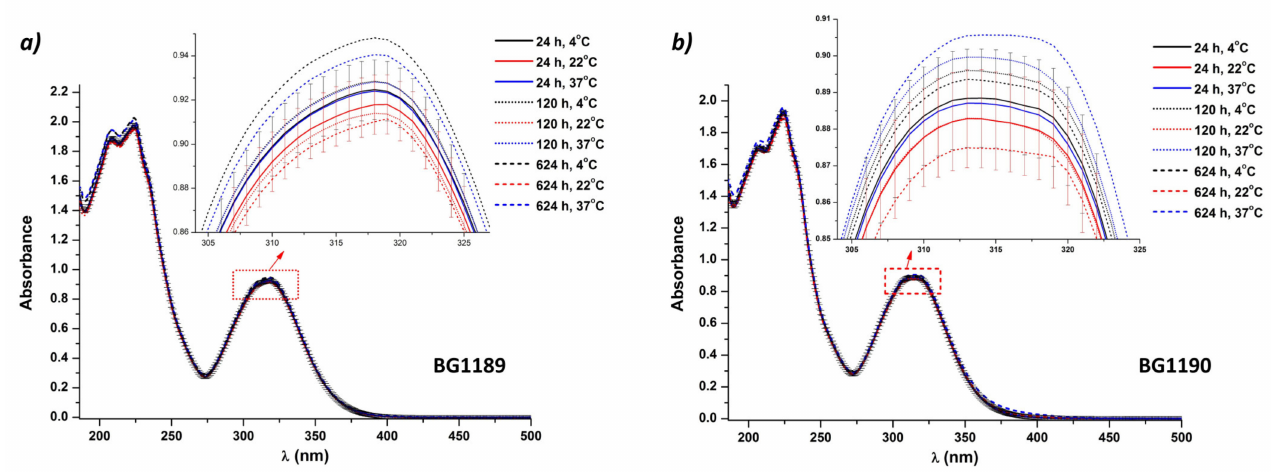
Figure 4. Influence of the storage temperature (4, 22 and 37 ◦ C) on the absorption spectra of: ( a ) BG1189 and ( b ) BG1190. Solutions prepared in ultrapure water at 10 − 3 M, kept in dark.